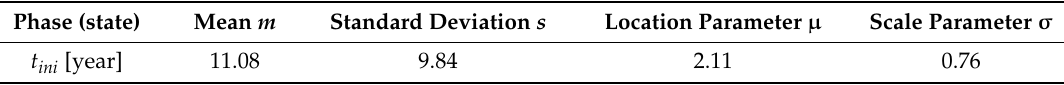
Table 15. Duration of time of initiation t ini of the process of carbonation-induced corrosion for the wings of the Weikendorf Bridge.